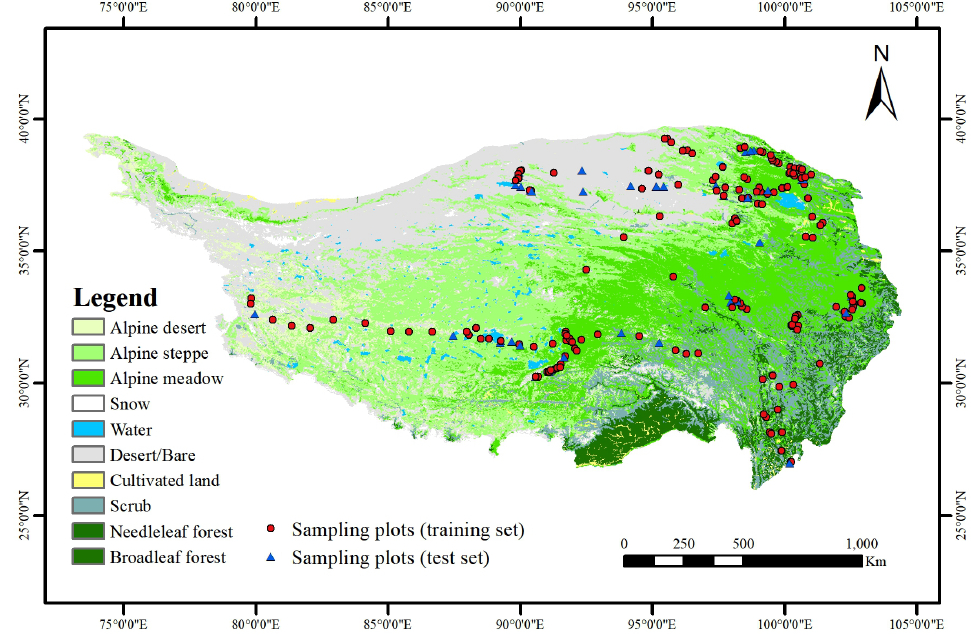
Figure 1. Spatial distribution of alpine grasses and AGB sampling plots on the Tibetan Plateau. The base map is the Alpine Grassland Map on the Tibetan Plateau